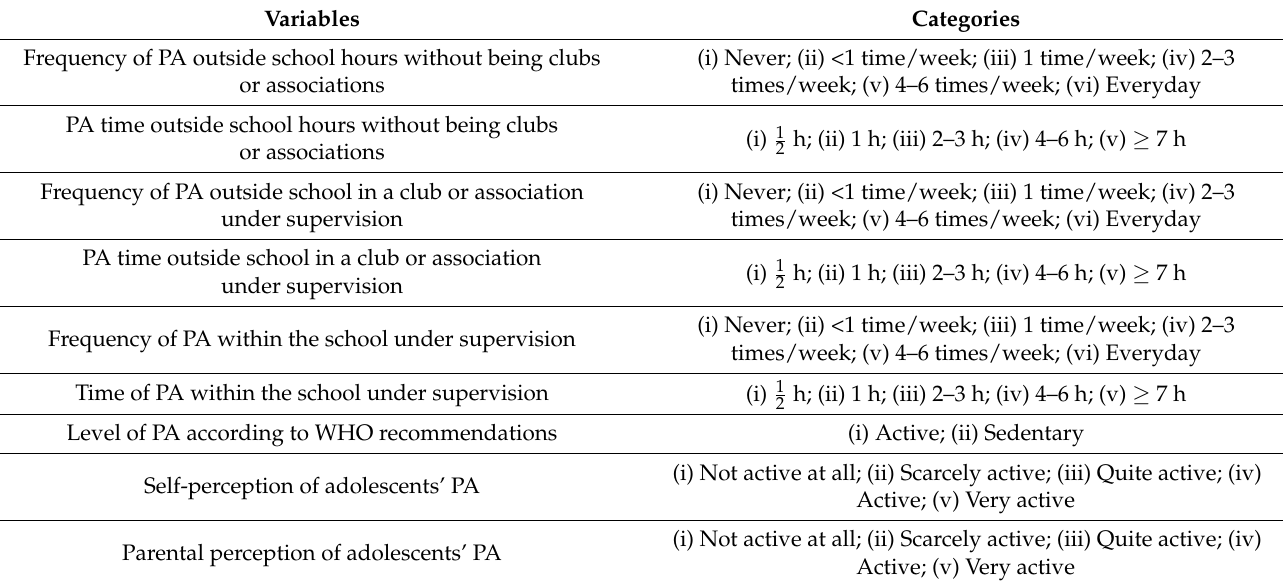
Table 2. Description of dependent variables